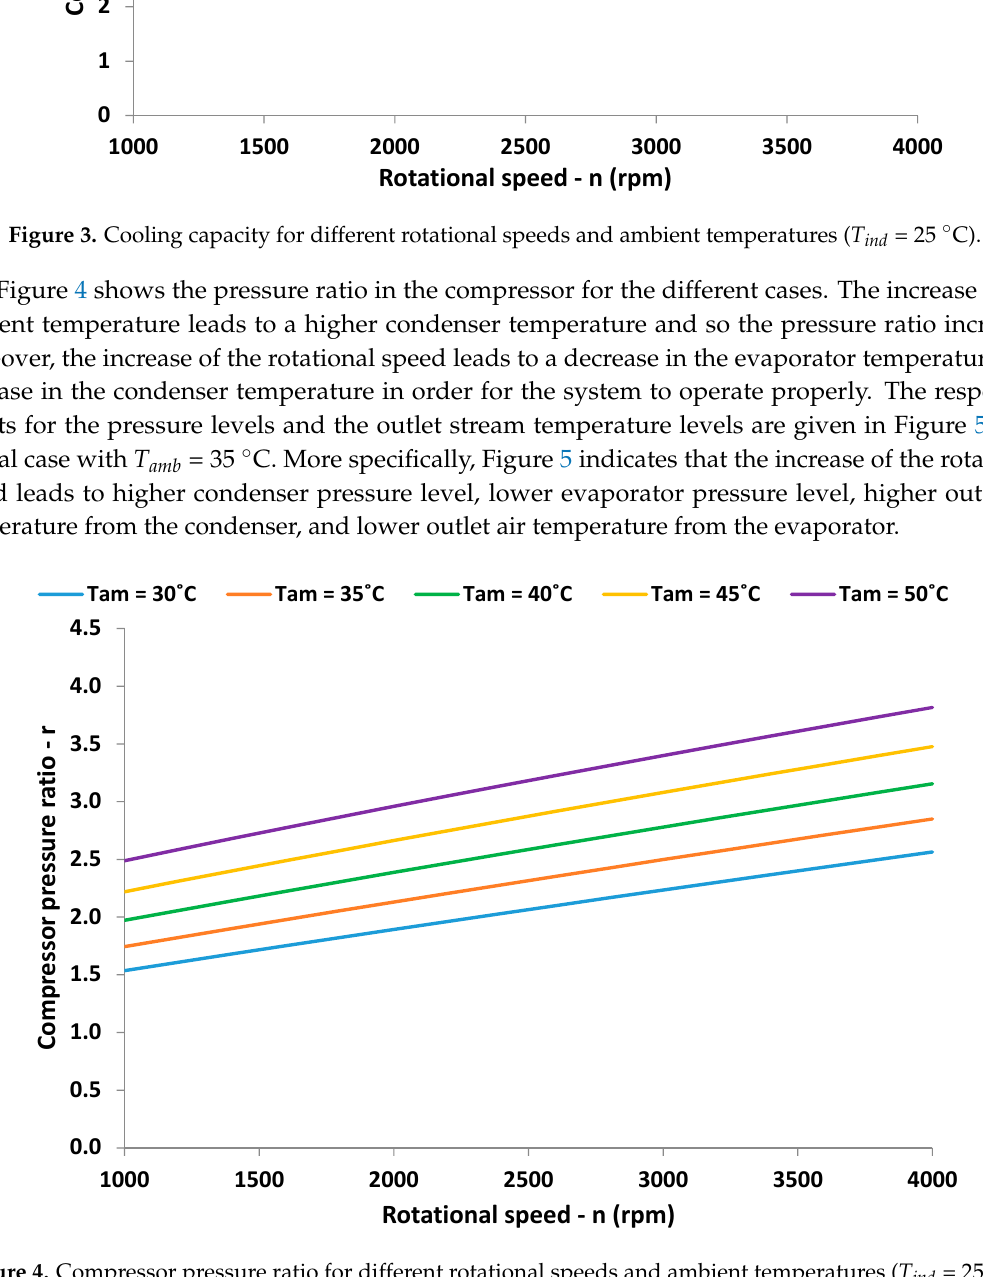
Figure 5. Pressure levels and outlet temperatures of the streams for different rotational speeds and ambient temperatures ( T ind = 25 °C). 3.2. Impact of the Ambient Temperature on the Performance